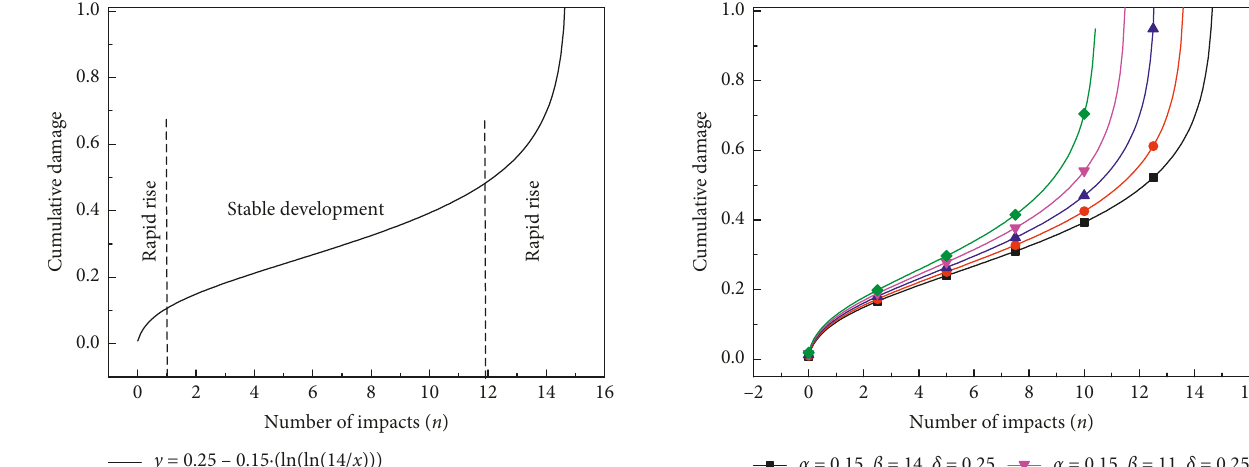
Figure 8: Cumulative damage model curve of siltstone under cyclic impact.